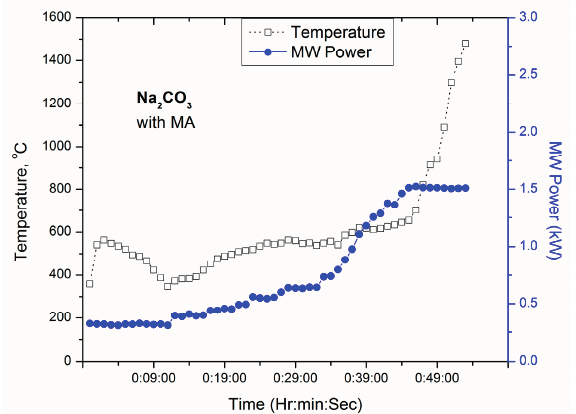
Figure 7. T-P-t profile of Na 2 CO 3 after 1 h exposure in microwave cavity with manually increased MW power up to 1.5 kW in presence of microwave